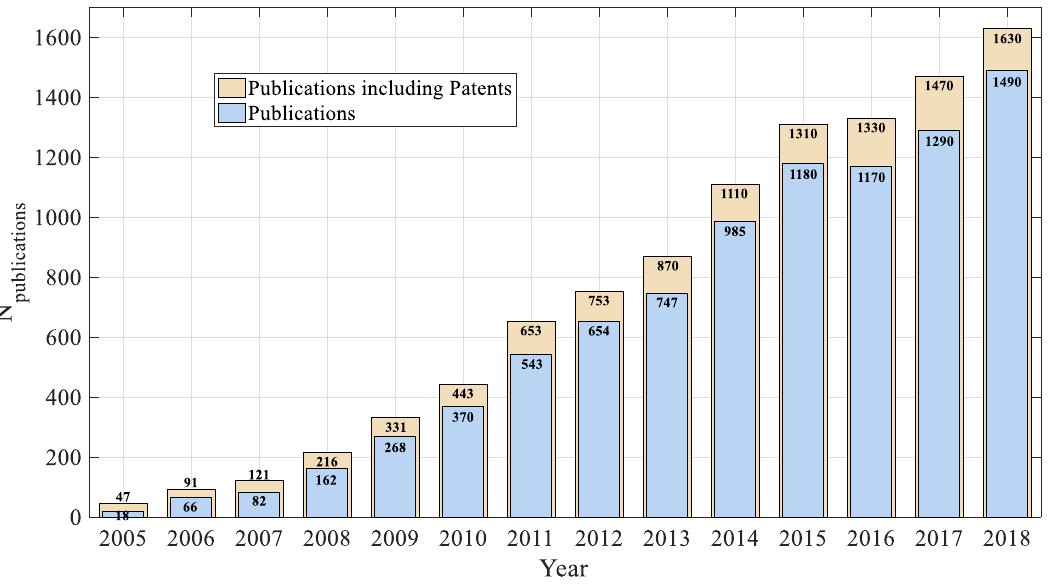
Figure 1. Publication profile regarding vibration energy harvesters (Source Google Scholar, Keyword Search: “Vibration Energy Harvesting” ).